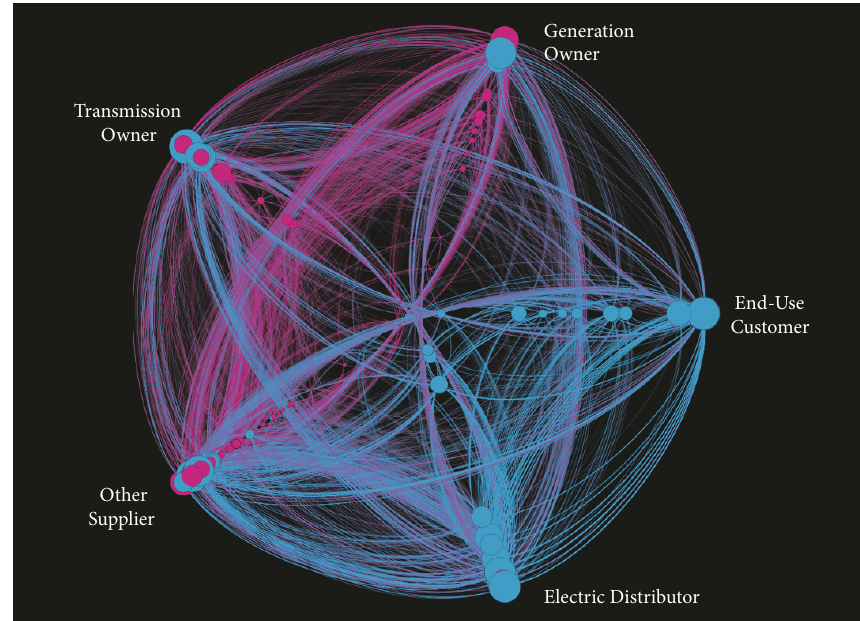
Figure5:TheyesvotingnetworkinthePJMMembersCommitteefrom2011to2015.Thenodeandedgecolorscorrespondtothetwodifferent communities detected within the yes